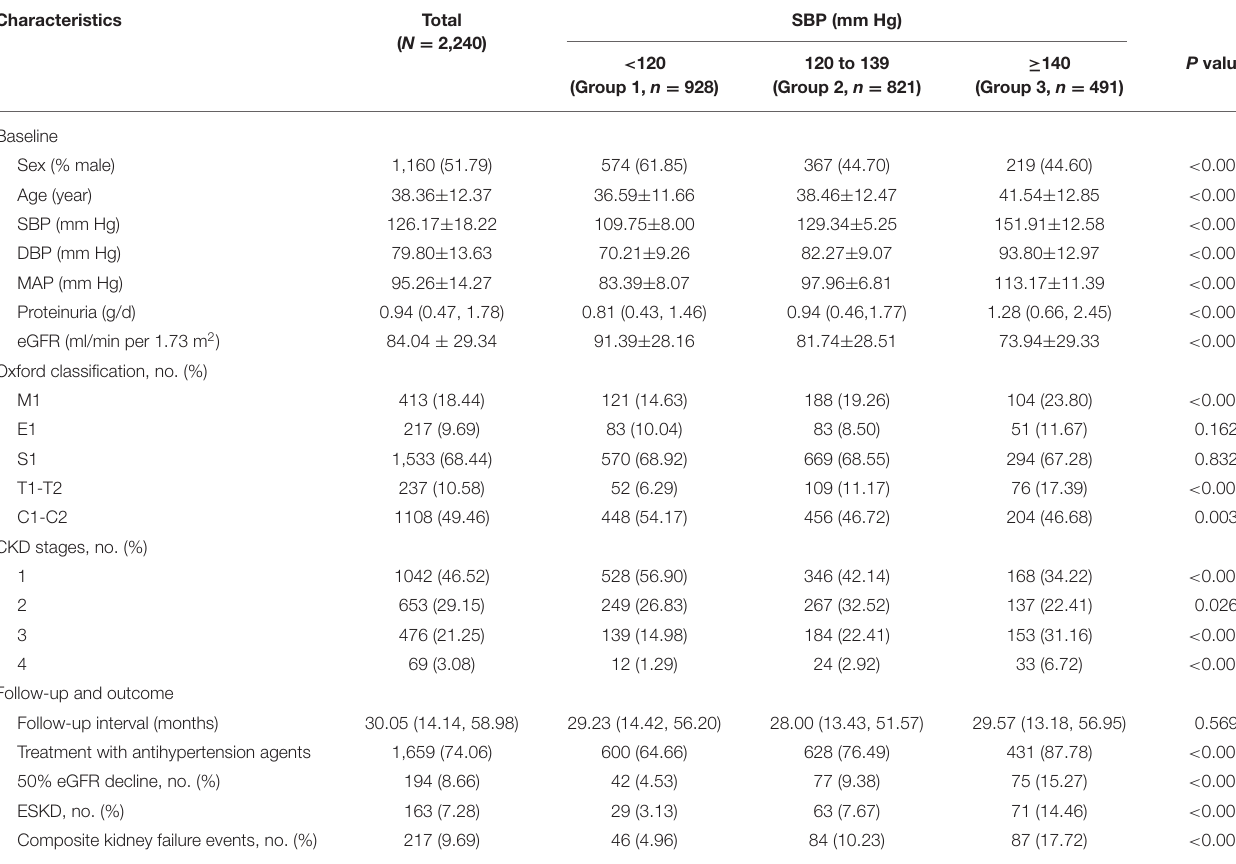
TABLE 1 | The characteristics of IgA nephropathy patients at the onset of renal biopsy.